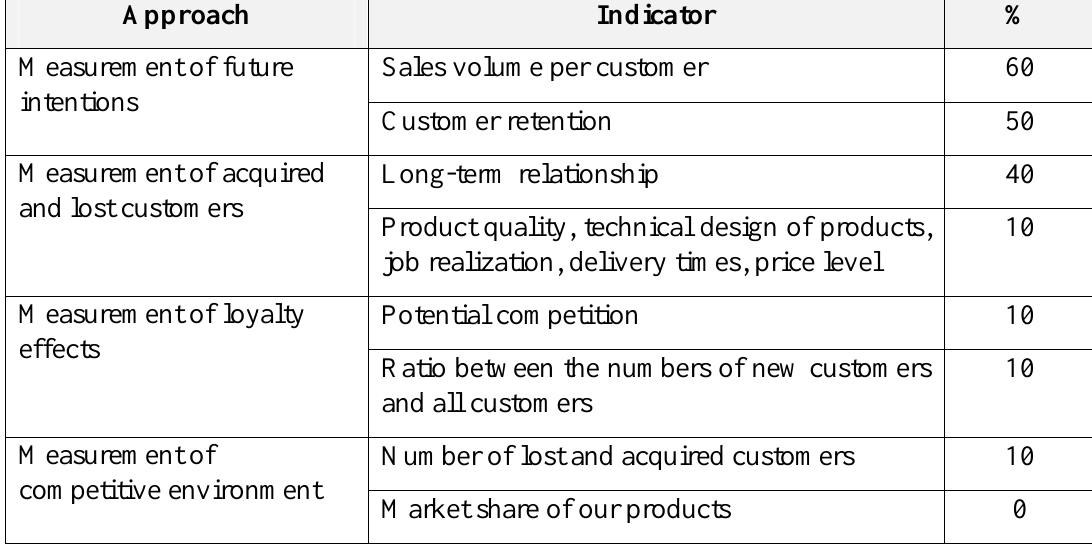
Tabel 2 – Customer loyalty measurement approaches and indicators (own